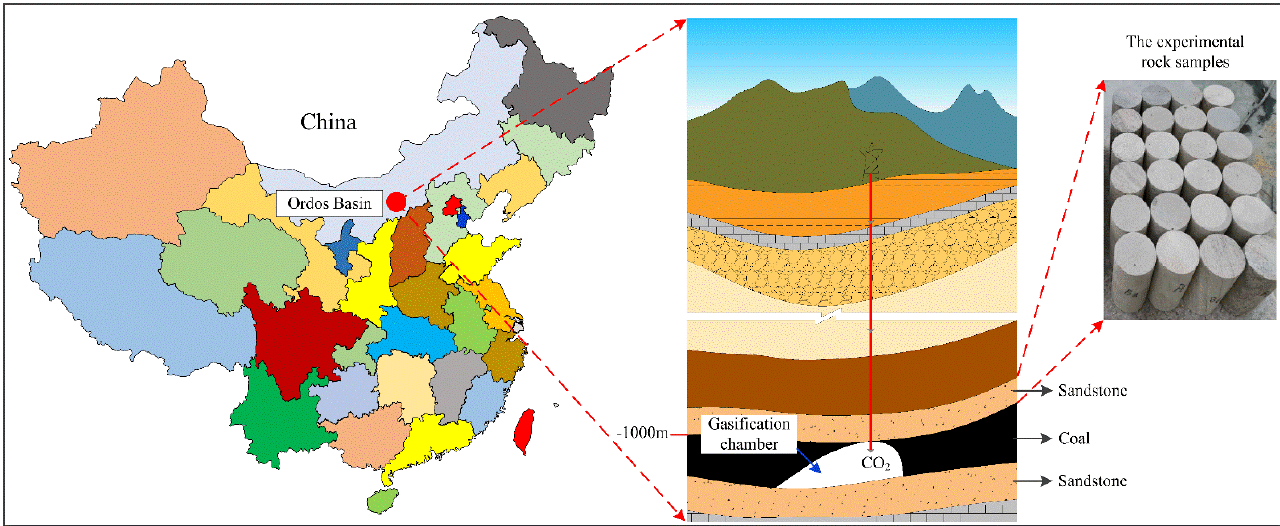
Figure 1. Schematic diagram of the sampling site for sandstone samples.